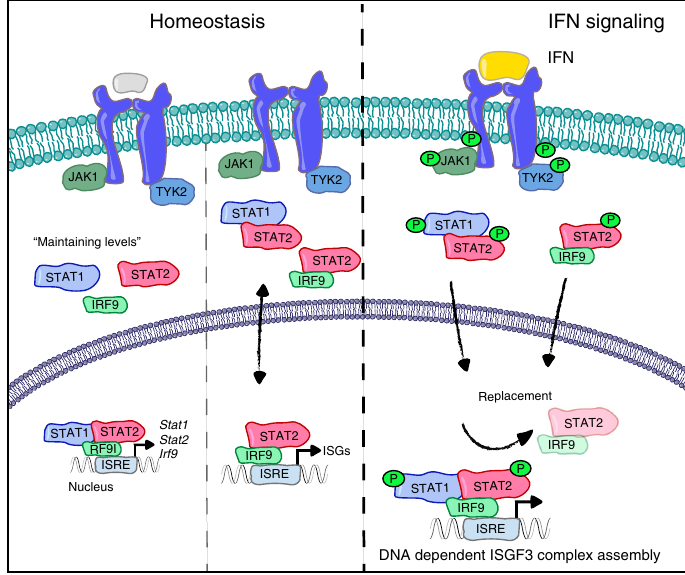
Fig. 8 Model of the molecular switch from resting to IFN-induced gene expression. Under homeostatic conditions, a tonic signal from the type I-IFN receptor activates small quantities of ISGF3, which increase basal expression of the genes encoding the ISGF3 subunits STAT1, STAT2, and IRF9. This causes the constitutive formation of STAT1 – STAT2 as well as STAT2 – IRF9 complexes. Basal expression of a large fraction of interferon-induced genes (ISGs) is stimulated by STAT2 – IRF9 complexes that appear in the nucleus without a signaling requirement. Signaling by the type I-IFN receptor and to a signi fi cant extent also by the IFN- γ receptor causes the formation of tyrosine-phosphorylated STAT1 – STAT2 heterodimers that translocate to the nucleus and form an ISGF3 complex by associating on DNA with IRF9. The higher off-rate of STAT2 – IRF9 compared with ISGF3 combined with a larger quantity of tyrosine-phosphorylated STAT1 – STAT2 versus STAT2 – RF9 complexes in IFN-treated cells most likely explains why a rapid exchange takes place